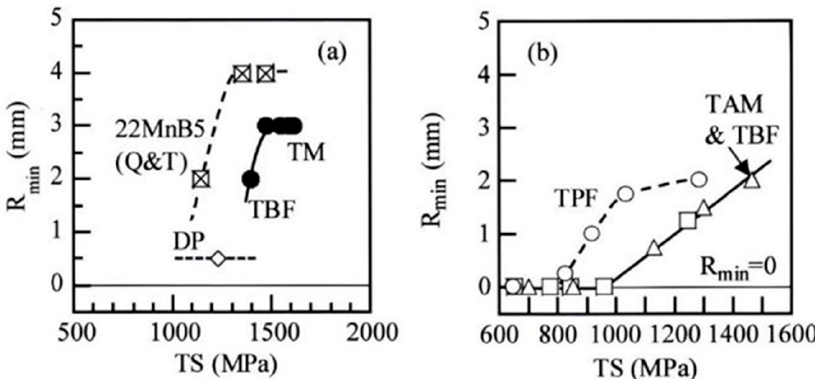
Figure 18. Relationships between minimum bending radius ( R min ) and tensile strength (TS) in ( a ) 0.21C-1.449Si-1.50Mn-1.0Cr-0.05Nb TBF and TM steels ( ● ), 0.082C-0.88Si-2.0Mn ferrite-martensite DP steel ( ◇ ), and 22MnB5 Q&T steel ( ⊠ ) [52] and ( b ) (0.1-0.6)C-1.5Si-1.5Mn TPF ( ○ ), TAM ( □ ), and TBF ( △ ) steels [99]. ( a ) is reprinted with permission from AIST, copyright 2022. ( b ) is reprinted with permission from ISIJ, copyright 2022.